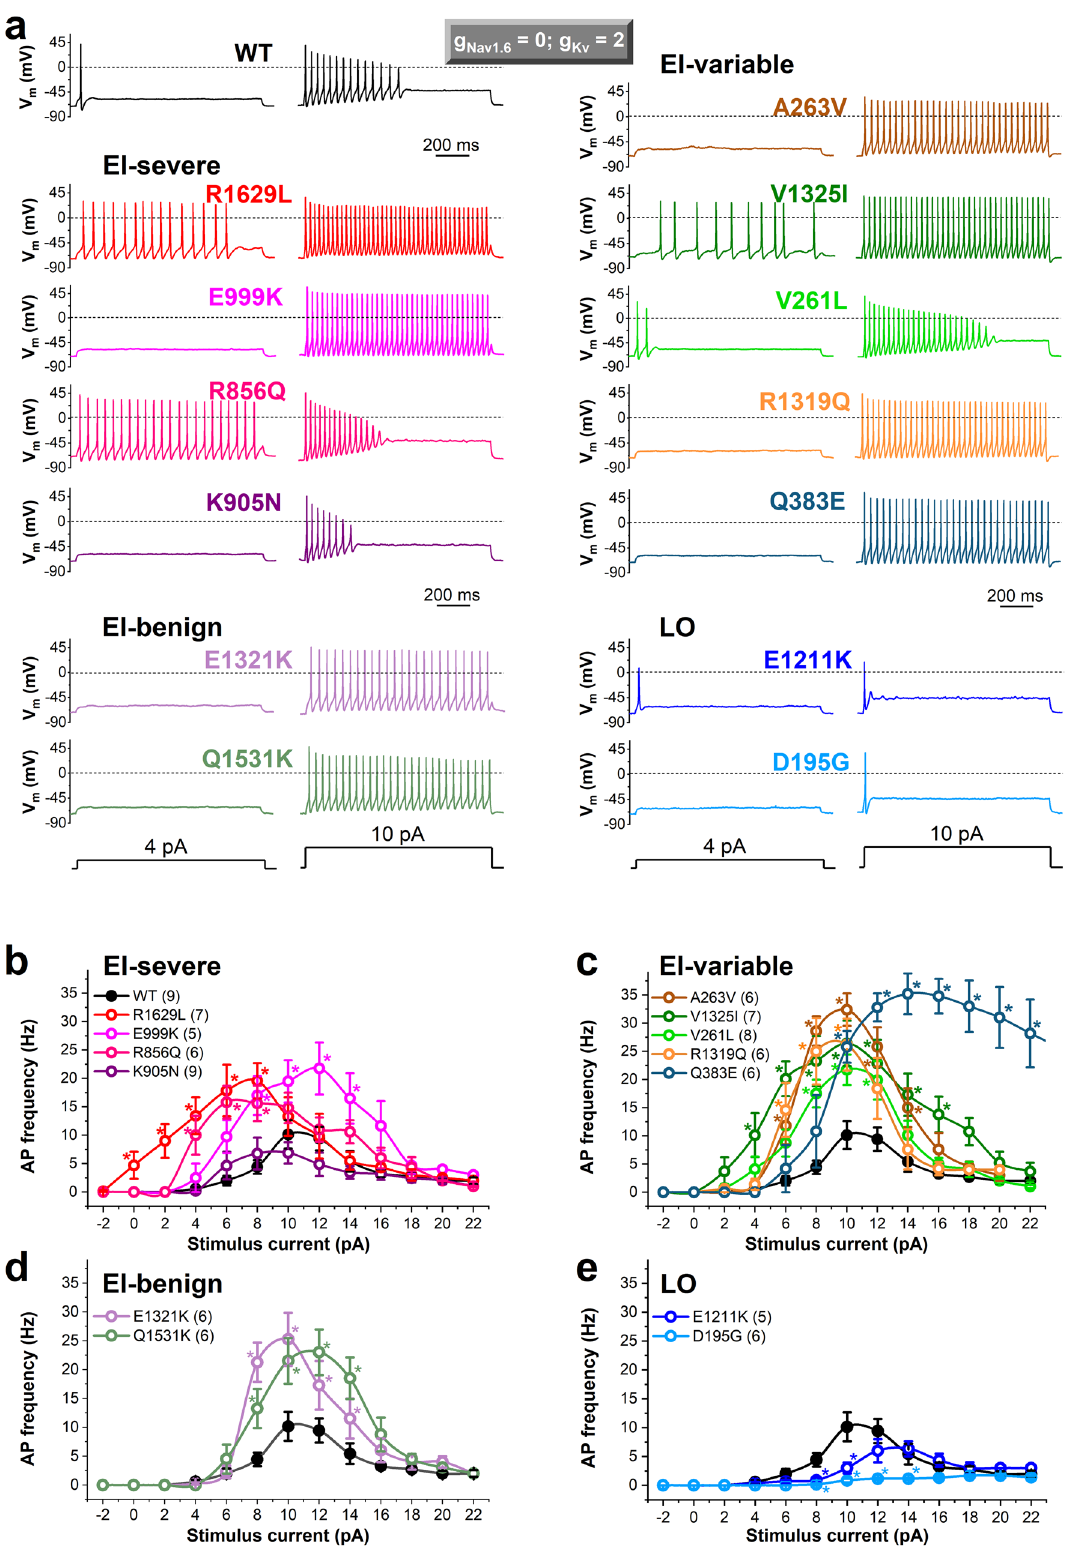
threshold, upstroke velocity, amplitude, width, and decay time. Action potential characteristics of several variants were altered relative to wild-type (Supplementary Table 6); the increased width and decay time of E999K, R856Q, A263V, V1325I, Q383, and Q1531K was correlated with increased persistent Na v 1.2 current for these variants in voltage clamp mode (Supplementary Fig.